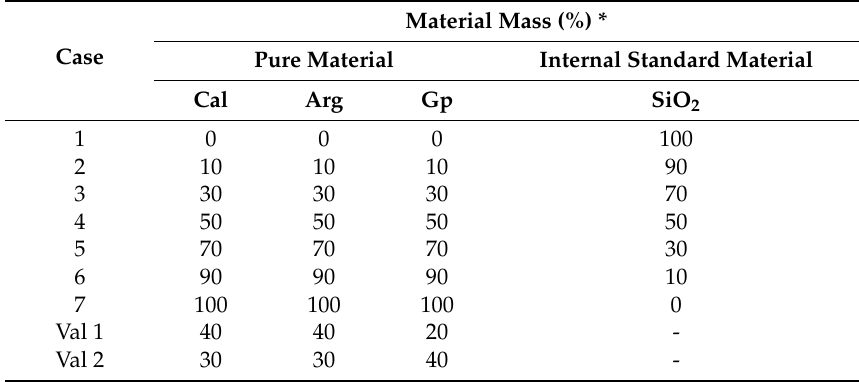
Table 2. Experimental conditions for calibration curve of quantitative analysis.